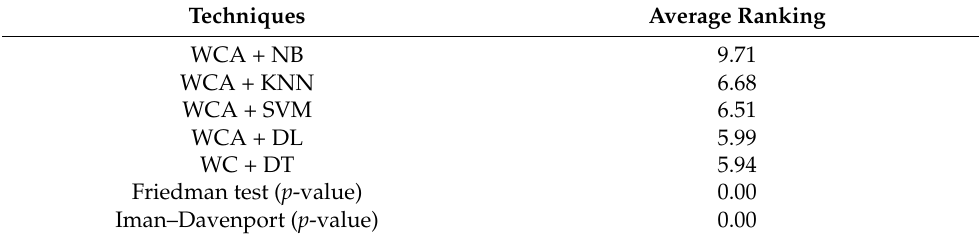
Table 8. Average ranking of Friedman test for WC with machine learning